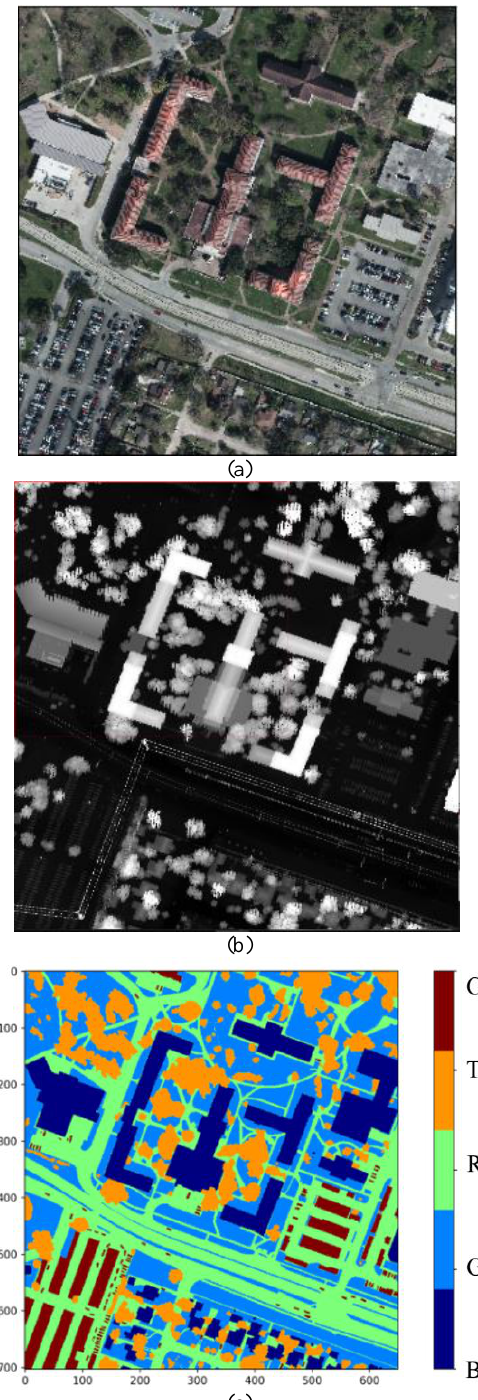
Figure 2. The grss_dfc_2018 data set over Houston. (a) VHR aerial image. (b) DSM (c) Ground truth